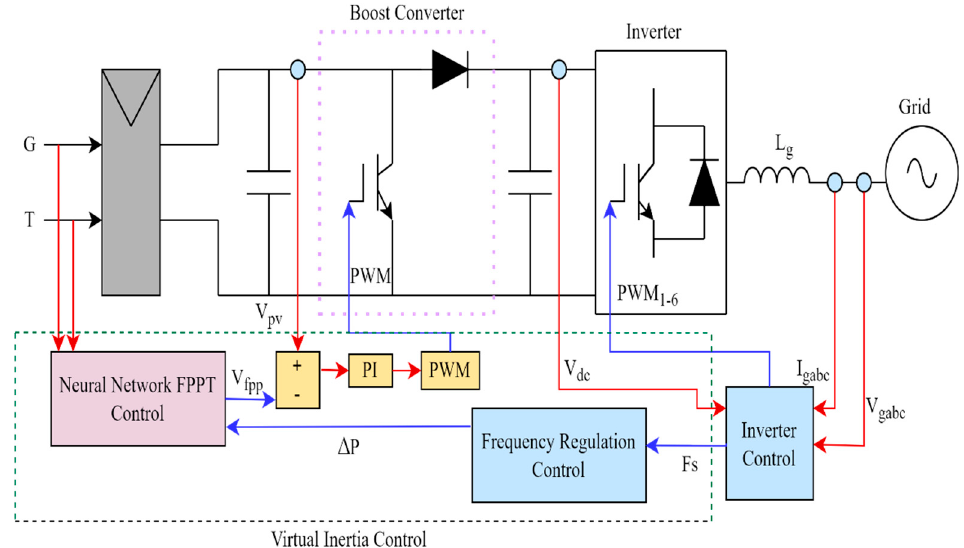
Figure 1. The photovoltaic two-level inverter system with proposed neural-network-based FPPT power reserve control for frequency regulation.